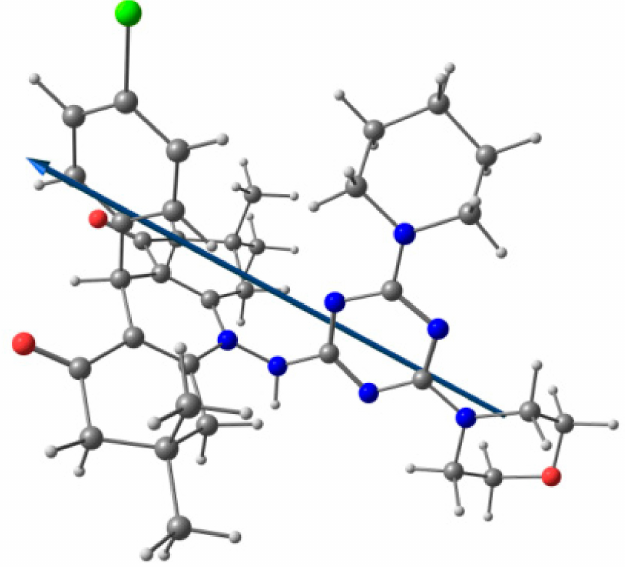
Figure 6. Optimized molecular structure showing the dipole moment vector of 4 ; C: Grey, N: blue, O: red and H: white.